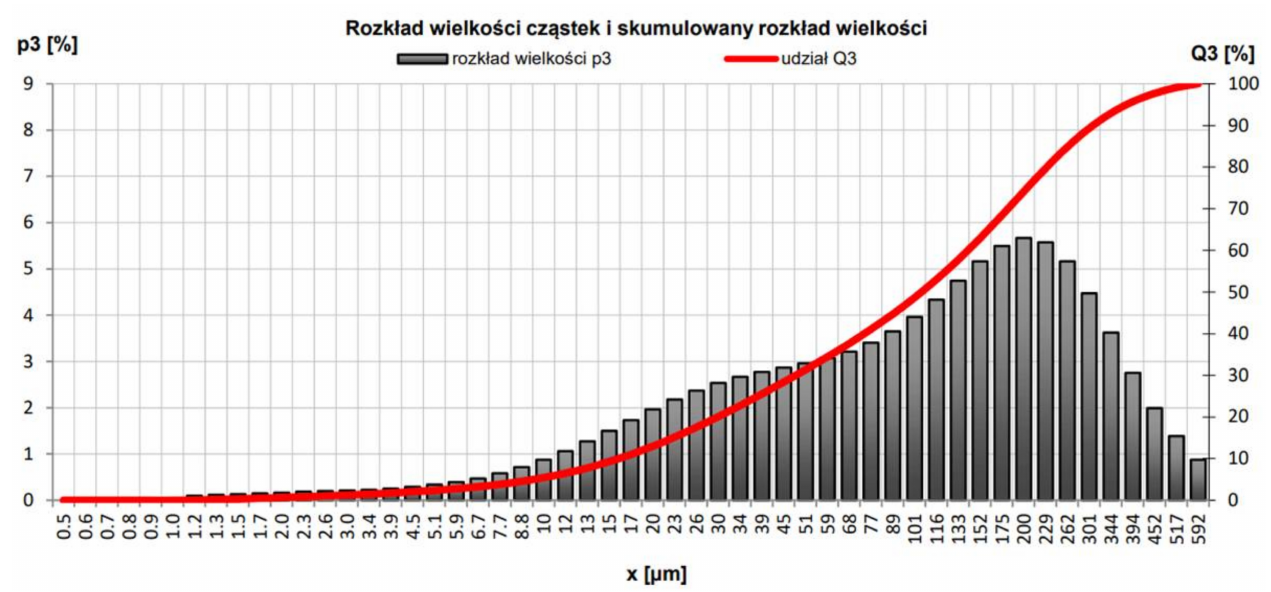
Figure 10. Particle size distribution and cumulative size distribution of FAC—fly ash from coal